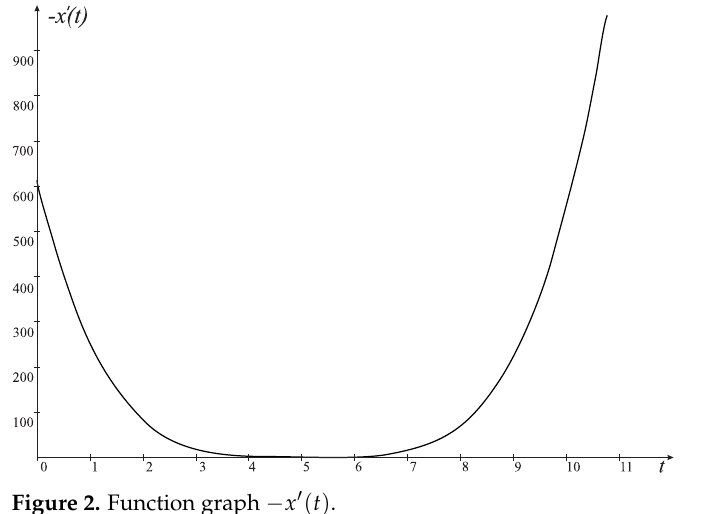
Figure 2. Function graph − x (cid:48) ( t )